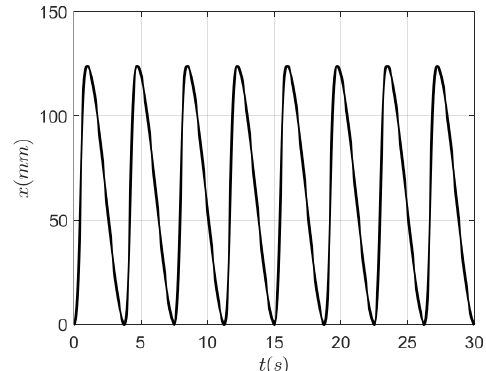
Figure 7. Angular velocity of the crank - case study 2